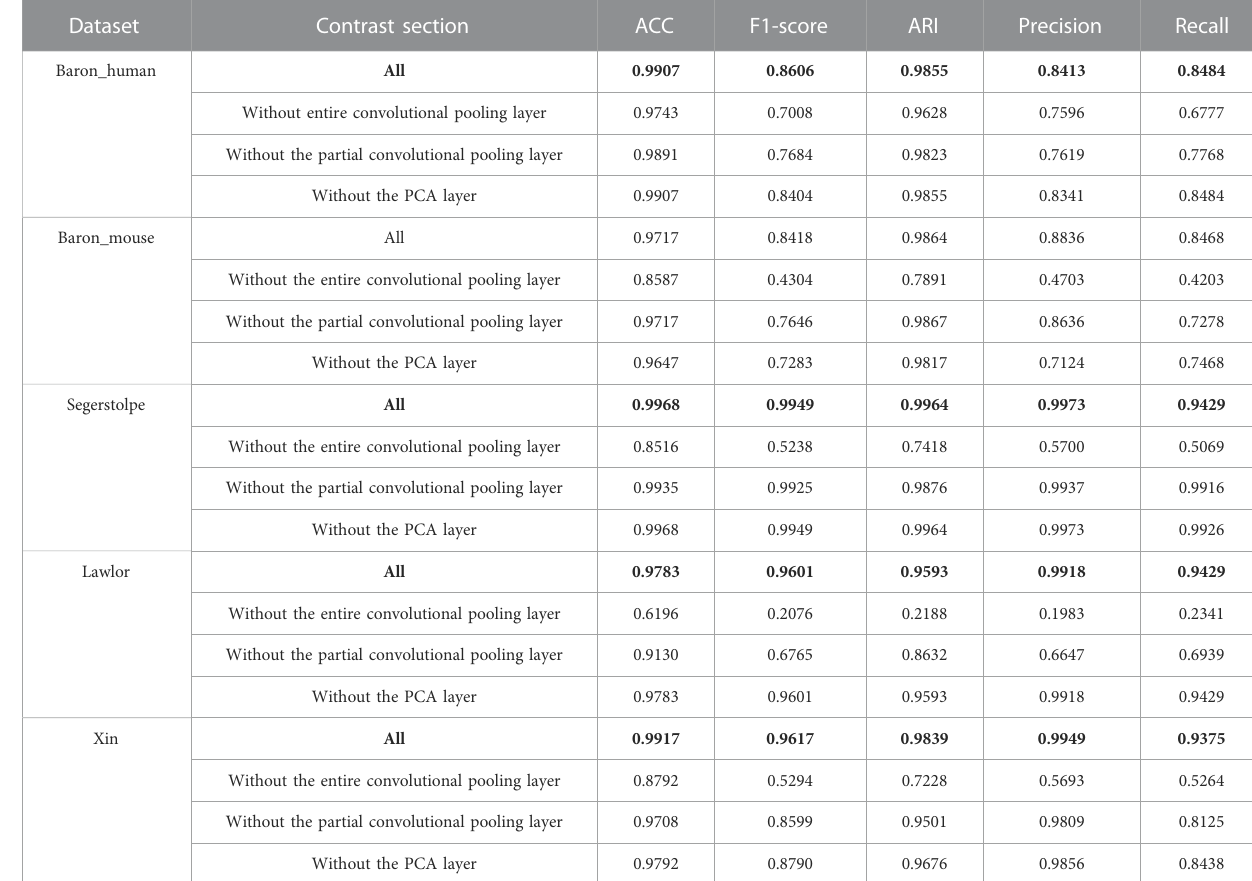
TABLE 4 Results of Ablation experiments.